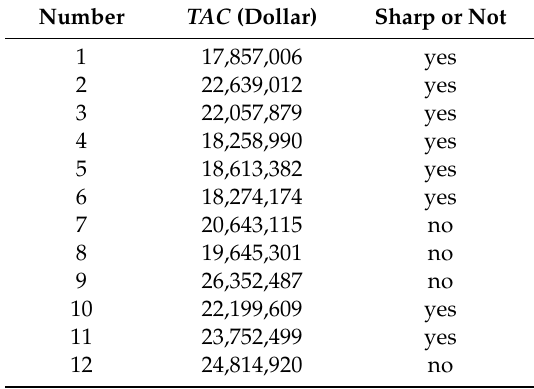
Table 8. Remaining sequences’ costs of the four-component alkane case after pruning. Number TAC (Dollar) Sharp or